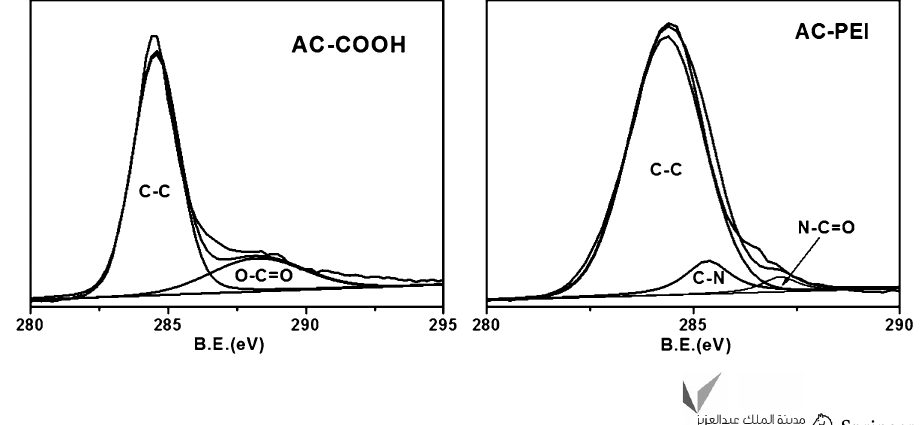
Fig. 3 Peak-fitted C1s signals of AC-COOH and